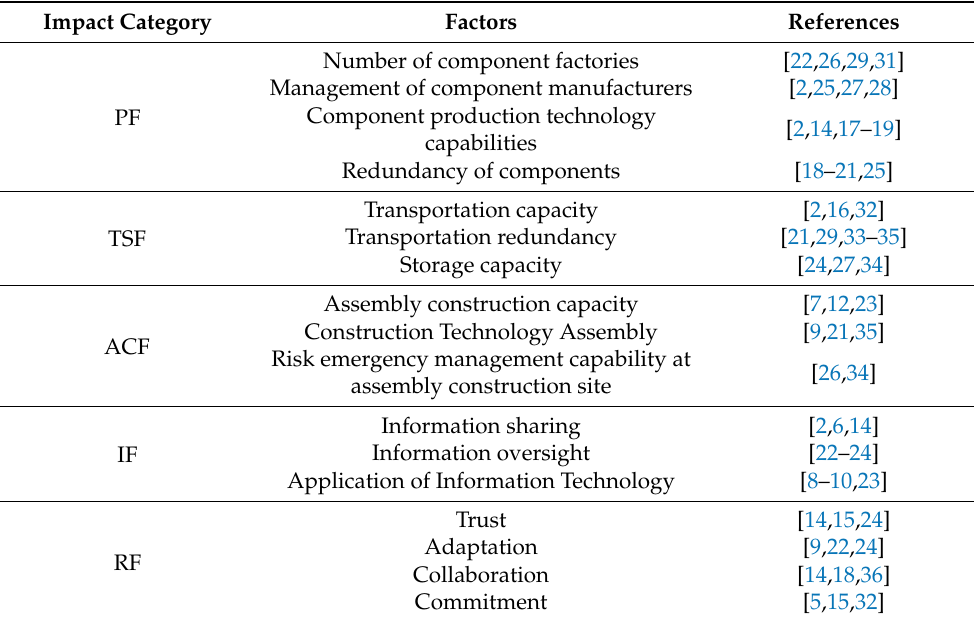
Figure 1. Conceptual model of factors affecting the resilience of PBSC. Table 1. Factors influencing the resilience of